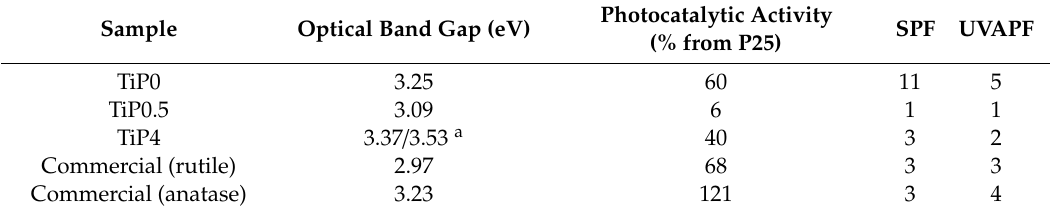
Table 2. Optical band gap, photocatalytic activity, SPF and UVAPF for brookite, anatase, and Table 2. phases (TiP0, TiP0.5, and TiP4 samples, respectively) and for commercially available anatase and rutile samples.